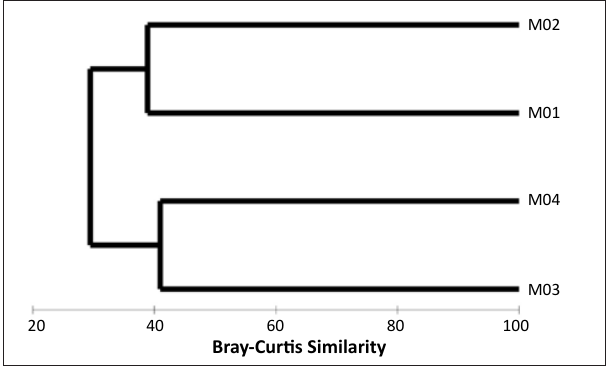
FIGURE 3: Dendrogram based on group average linking of Bray–Curtis similarity matrix of ant assemblages at the four sampling The least represented subfamilies were Dolichoderinae, with six species of Tapinoma , and Dorylinae, with three species of Dorylus .